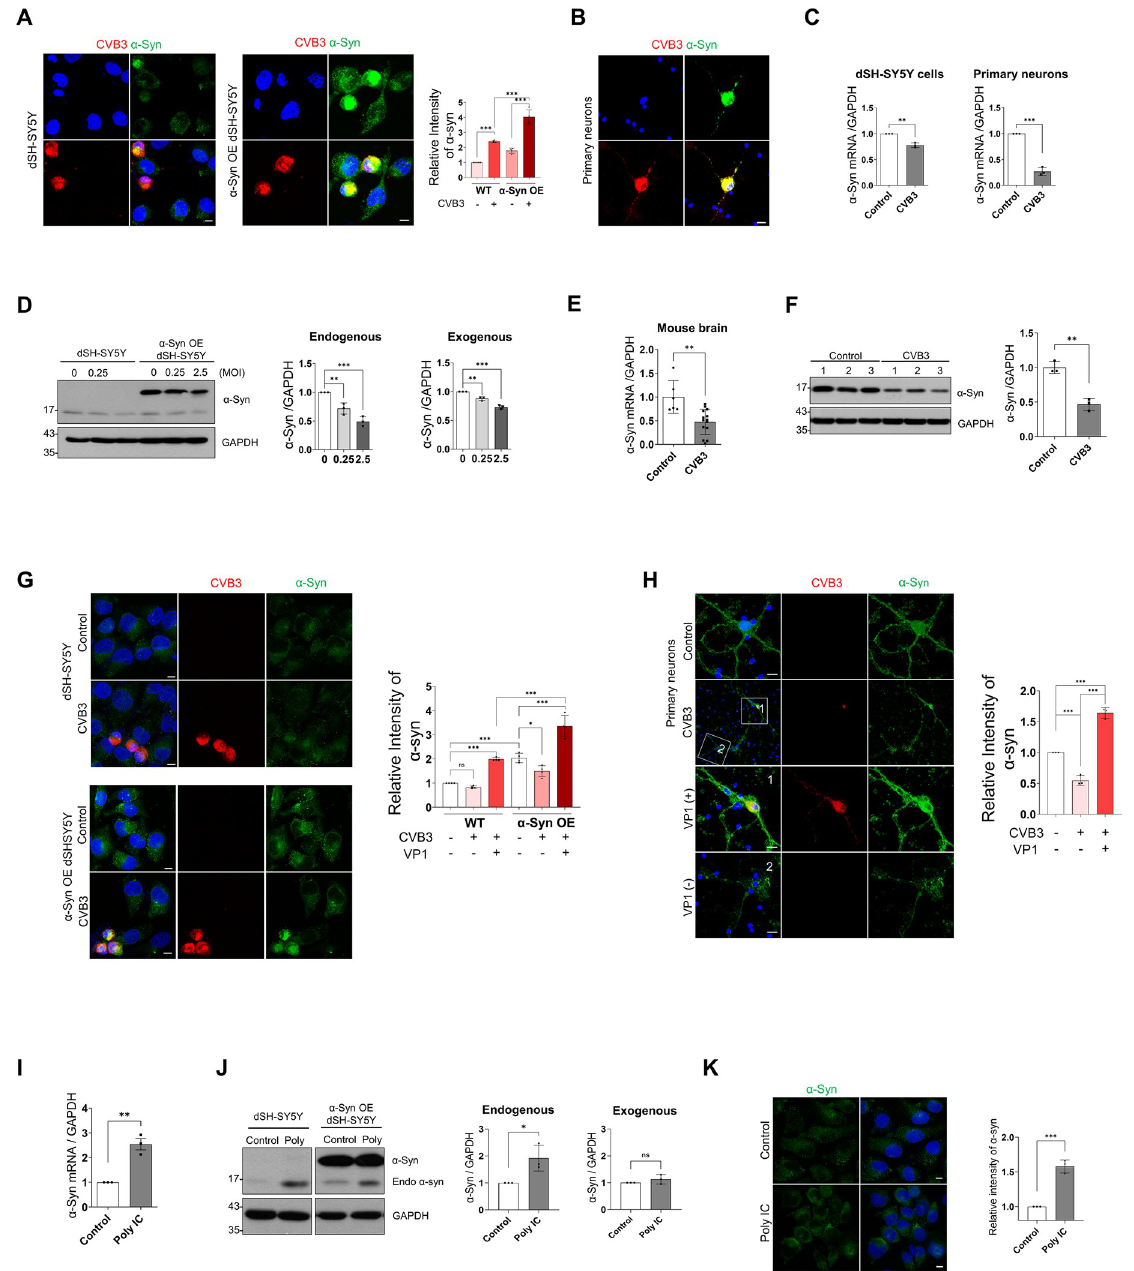
Fig 1. CVB3 infection regulates α -syn expression in neurons. (A) Immunocytochemistry (ICC) images of WT and α -syn OE dSH-SY5Y cells infected with CVB3 (MOI 0.25) (red) for 24 h. The intensity of α -syn (green) was analyzed. Values are derived from four independent experiments (n = 4). ��� P < 0.001, one-way ANOVA test with Tukey’s multiple comparison test. (B) ICC images of mouse primary cortical neurons infected with CVB3 (MOI 5) for 24 h. Scale bar indicates 10 μ m. Blue indicates Hoechst. (C) The relative expression levels of α -syn mRNA between control, CVB3-infected dSH-SY5Y cells (MOI 0.25) and mouse primary cortical neurons (MOI 5) infected with CVB3 for 24 h. Values are derived from three independent experiments (n = 3). ��� P < 0.001, �� P < 0.01, unpaired t-test. (D) WT and α -syn OE dSH-SY5Y cells were infected with the indicated MOIs of CVB3 for 24 h. Western blotting was performed with the indicated antibodies and protein levels were quantified by densitometry. Values are derived from three independent experiments (n = 3). ��� P < 0.001, �� P < 0.01, one-way ANOVA test with Tukey’s multiple comparison test. (E) The relative levels of α -syn mRNA expression between control (n = 6) and CVB3 infected mice brain hemispheres (n = 14) after 4 days of intraperitoneal (IP) injection with 1.0 × 10 6 plaque forming units (PFUs) of CVB3 in 100 μ l of PBS. �� P < 0.01, unpaired t-test. (F) The relative levels of α -syn expression between control (n = 3) and CVB3 infected mice brain hemispheres (n = 3) after 7 days IP injection with 1.0 × 10 6 PFUs of CVB3. Western blotting was performed with the indicated